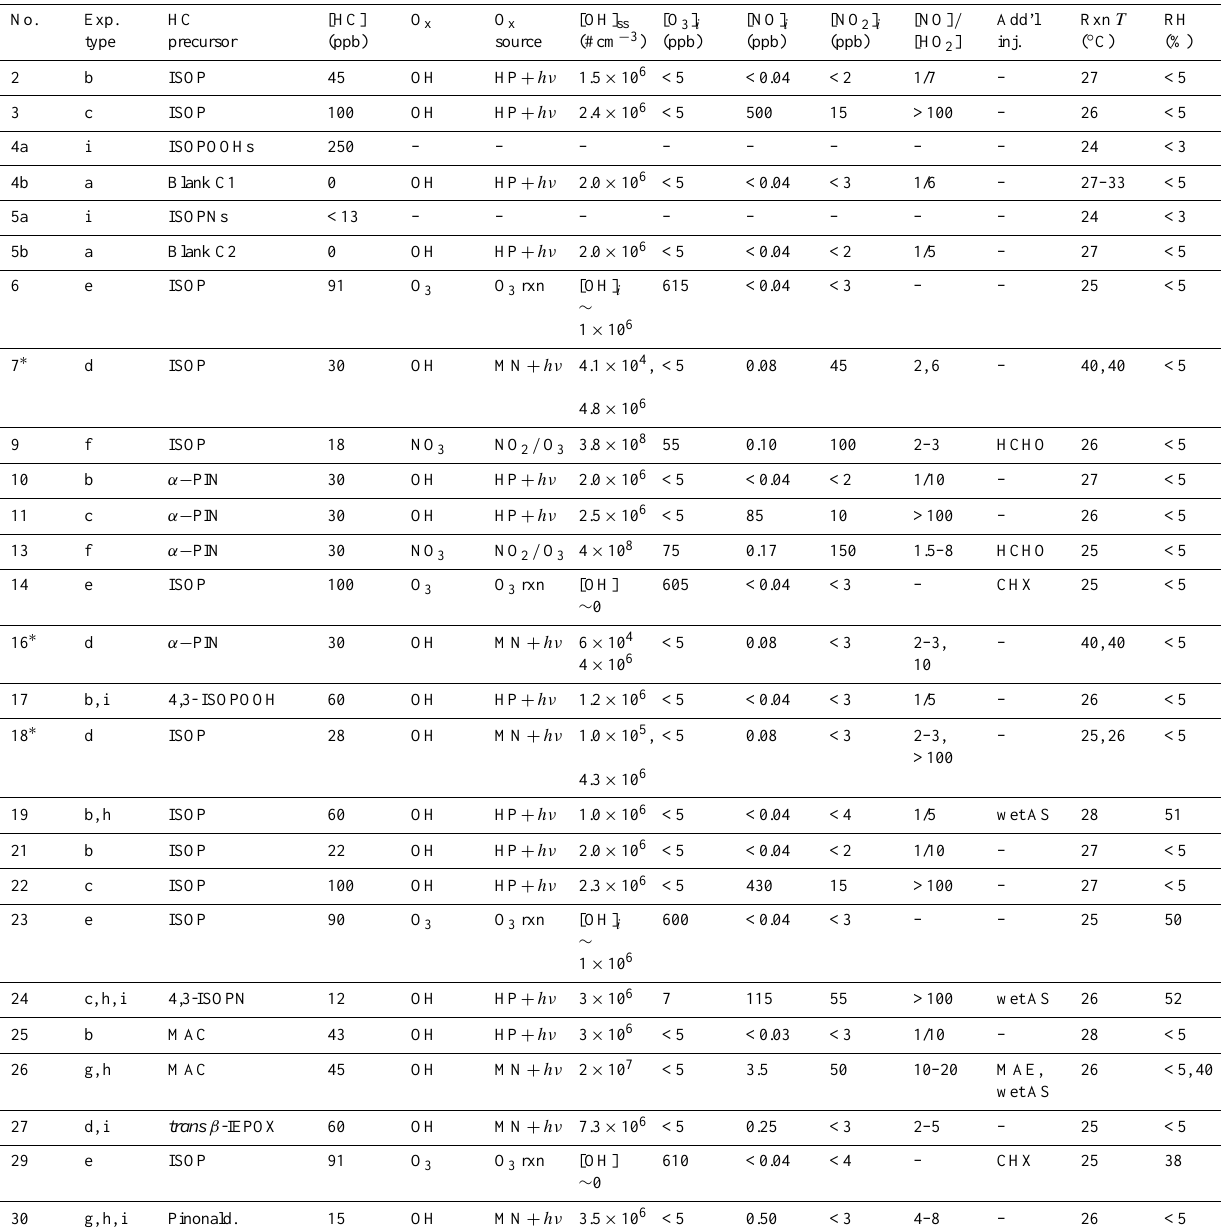
Table 2. Formal experiments and reaction conditions during the campaign. Chemical abbreviations are defined in Table 3. Other ab- breviations are C1 = Chamber 1, C2 = Chamber 2, ISOP = isoprene, α -PIN = α -pinene, HP = hydrogen peroxide, MN = methyl nitrite, CHX = cyclohexane, HCHO = formaldehyde, AS = ammonium sulfate seeds. Exp. types are defined in the text. Exp. no. corresponds to